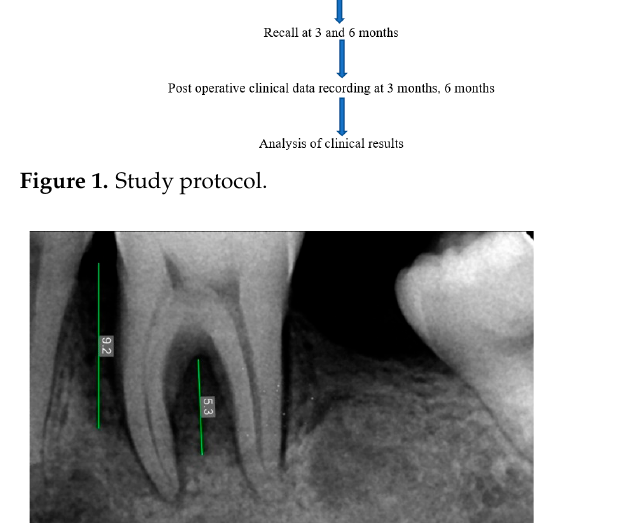
Figure 2 . Pre-Operative X-Ray of 36 showing bone defect .